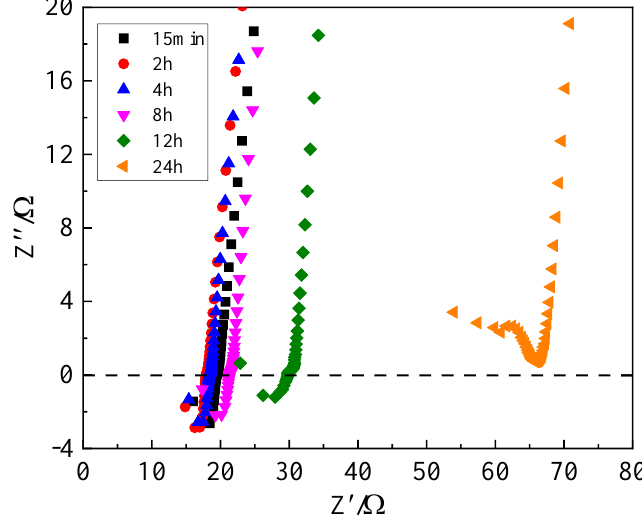
Figure 3. The Nyquist plots of cement paste with 1% NMK addition. As can be seen from Figure 4, the Bode plots with impedance modules of NP1 cement paste followed the same pattern of variation as that of ordinary cement paste. When the applied frequency was low (0.01 Hz), the NP1 cement paste impedance had a larger response to the disturbance. At the hydration times of 15 min, 2 h, 4 h, 8 h, 12 h and 24 h, the NP1 cement paste impedance moduli were 27.8 kΩ, 31.6 kΩ, 32.9 kΩ, 35.9 kΩ, 39.0 kΩ and 42.7 kΩ, respectively. When the applied frequency was 7 MHz, the impedance moduli of the cement paste at 15 min, 2 h, 4 h, 8 h, 12 h and 24 h were 16.1 Ω, 15.0 Ω, 15.4 Ω, 17.4 Ω, 22.9 Ω and 54.1 Ω , respectively. This phenomenon also indicated that NP1 cement paste hydrates faster and has more hydration products in the same hydration period. Nanopar- ticles filled the voids between larger cementitious particles and yielded a denser packing of cementitious particles at the nanoscale. Moreover, nanoparticles provided a seeding surface for hydrate deposition and promoted cement hydration, accelerating the for- mation of hydration production [37]. The denser packing and the hydration products pro- moted the formation of internal structural buildup, and the channels for ion transports were blocked over time. Therefore, the hinder effect for the current conduction in the ce- ment paste increased with NMK addition, and the impedance modules increased.